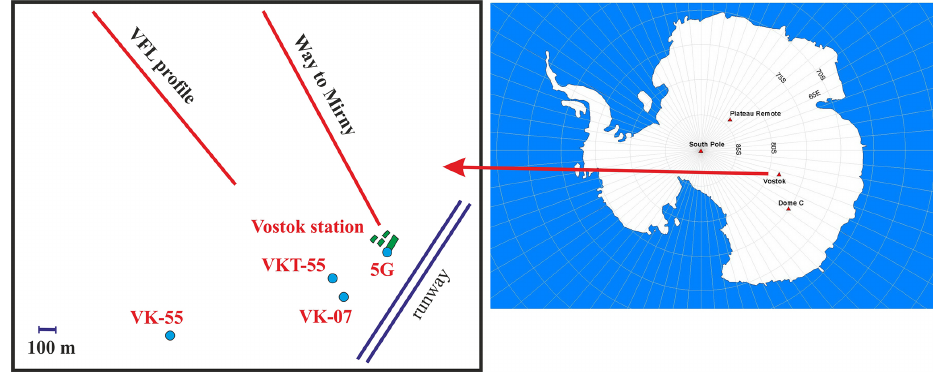
Fig. 1. Locations of the Vostok station and core sites used in this study (left side). Other Antarctica core sites mentioned in the text are also indicated (right